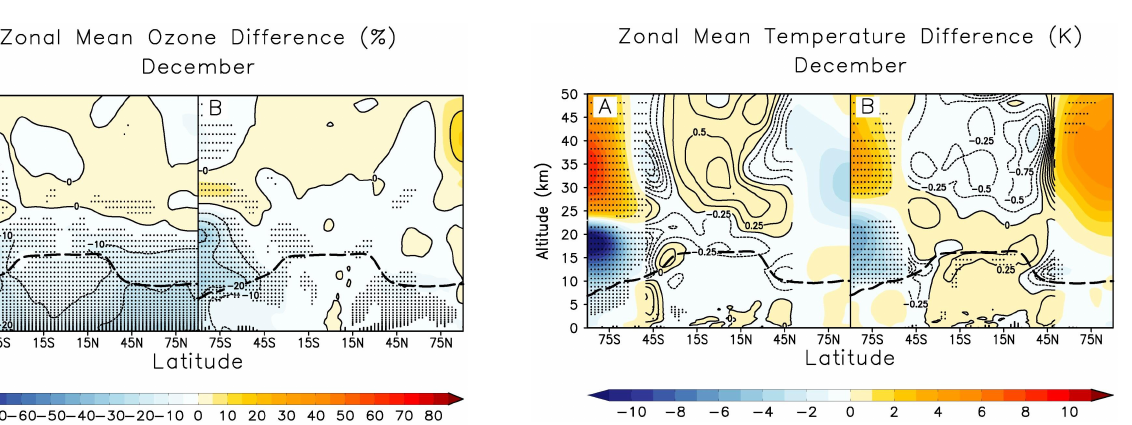
Figure 6: December zonal and monthly mean ozone differences in percent (relative to the mean volume mixing ratio in the “Control” run) for experiment pair A (left) and experiment pair B (right). Negative differences are shown in cold colours and positive in warm colours. The black dashed line indicates the position of the tropopause in the base cases. Differences that exceed one standard deviation of the ‘Control’ are stippled.